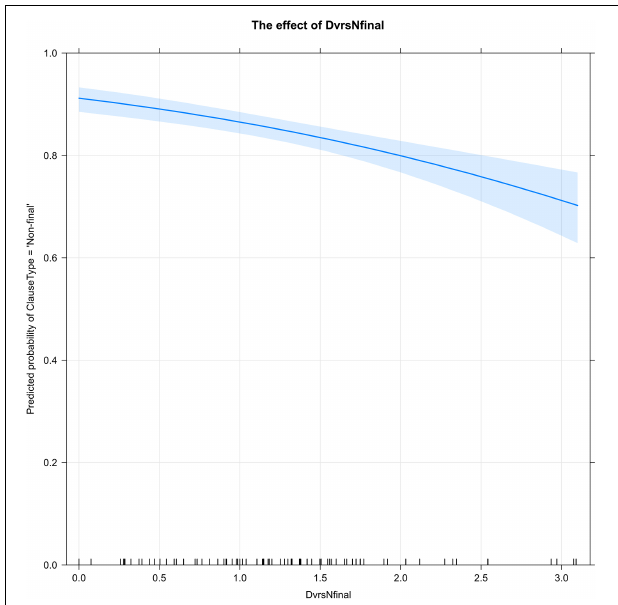
FIGURE 5 | The diversity of connectives in non-final clauses (DvrsNfinal) is represented by values of H along the x -axis. As the diversity of connectives increases, the probability of clause linking (ClauseType = ‘Non-final’) decreases. The ticks along the x -axis show that most stories have a high (80–90%) percentage of linked clauses and a moderate (0.25 – 1.75) diversity of connectives in non-final